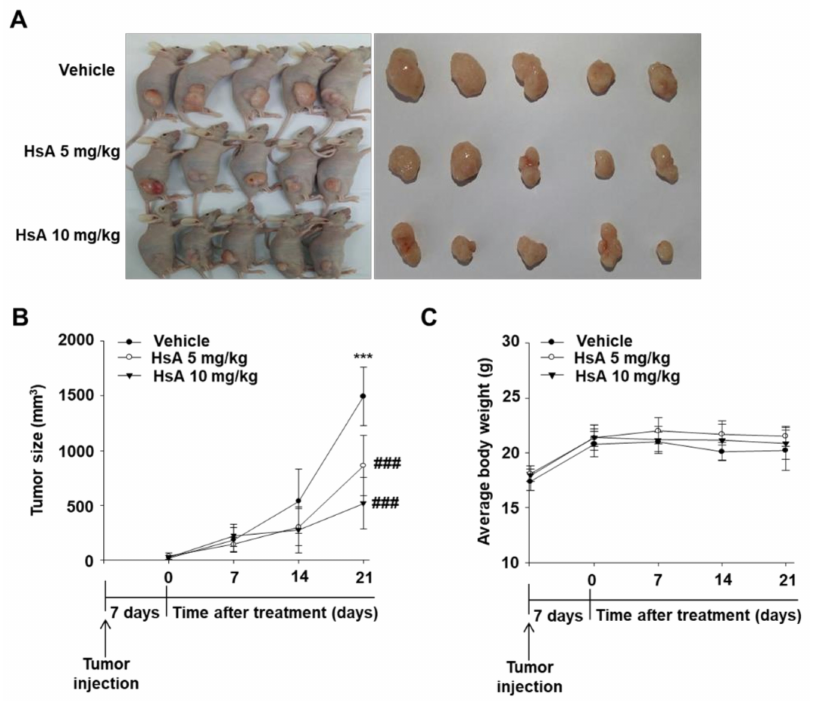
Figure 6. Hemistepsin A (HsA) inhibits the growth of human prostate cancer xenograft in vivo. ( A , B ) Tumor volume. ( C ) Mouse body weight. *** p < 0.001 compared with the 0 day; ### p < 0.001 compared with the HsA treated